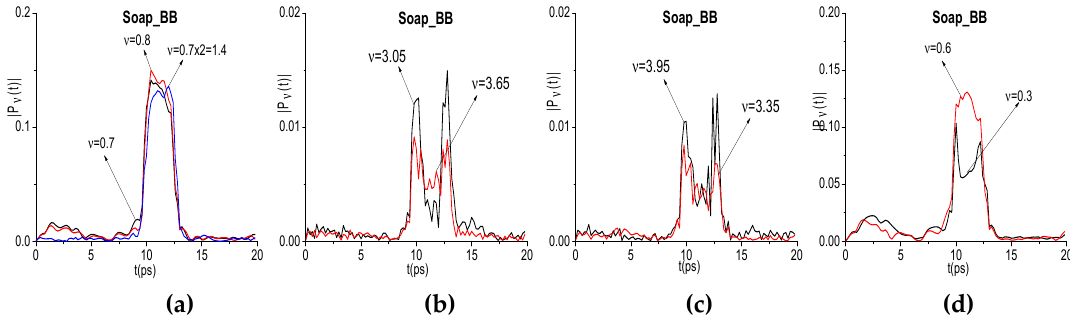
Figure 16. Evolution of Soap_BB spectral amplitude modulus at the frequencies: ν = 0.7, 0.8, 1.4 THz (a), 3.05, 3.65 THz (b), 3.35, 3.95 THz (c), and 0.3, 0.6 THz (d).